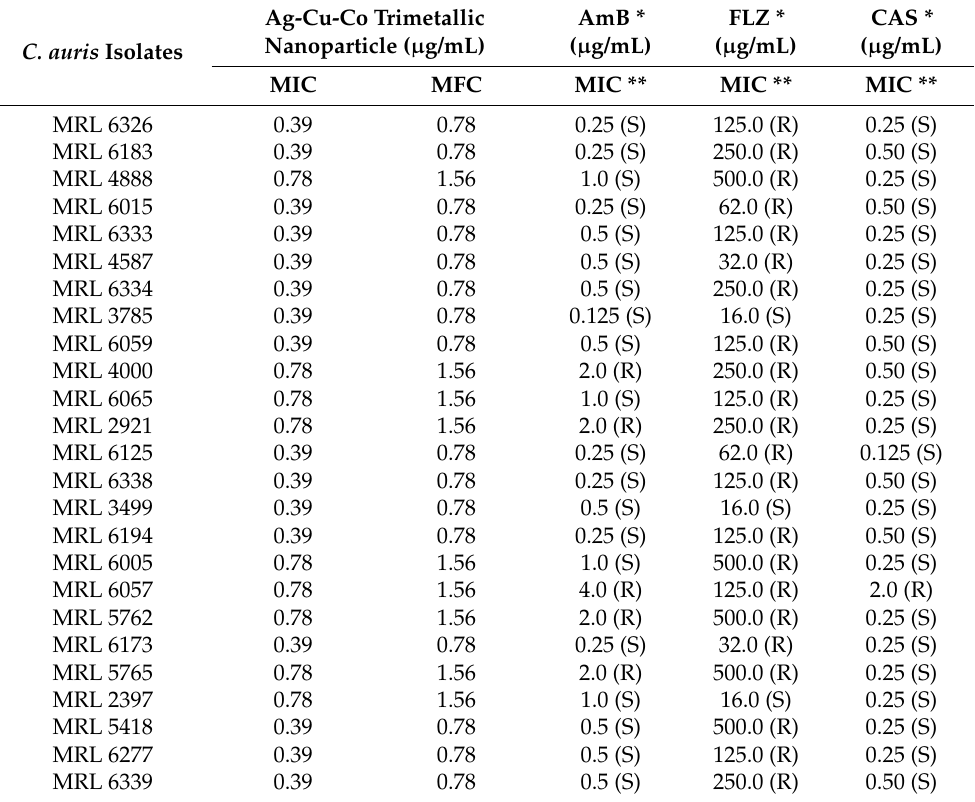
Table 2. Minimum Inhibitory Concentrations (MIC) and Minimum Fungicidal Concentrations (MFC) of Ag-Cu-Co Trimetallic nanoparticles and three antifungal drugs representing azoles, polyenes and echinocandins against C. auris isolates ( n =